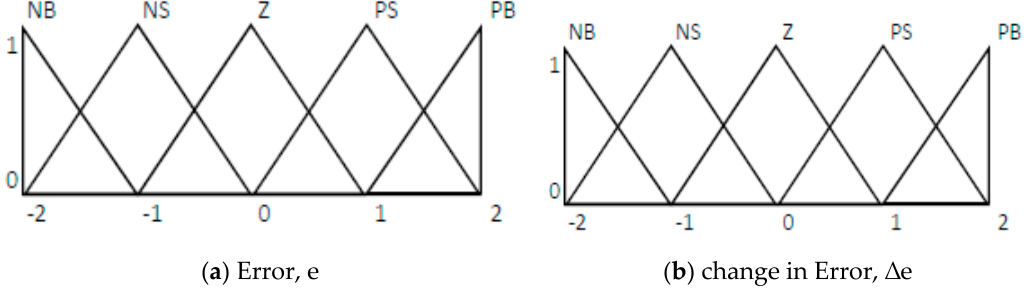
Figure 3. Input membership functions.